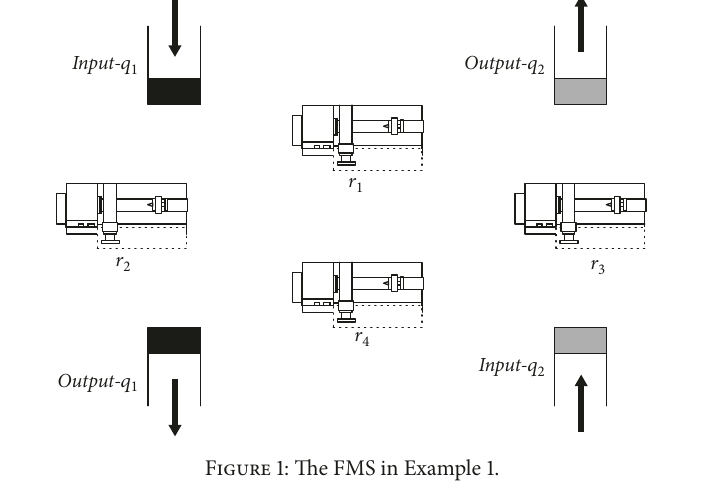
Figure 1: The FMS in Example 1.